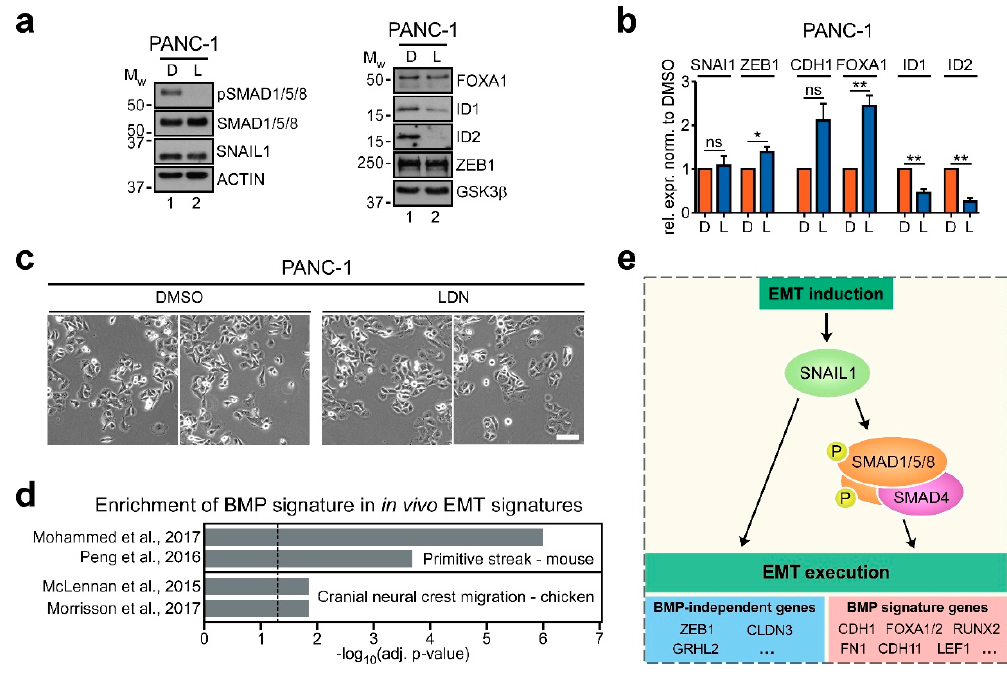
Figure 7. BMP pathway activity partially sustains a mesenchymal state of pancreatic cancer cells and BMP signature gene expression occurs in developmental instances of EMT. ( a ) Western blot analyses of proteins indicated on the right. PANC-1 cells were treated with DMSO or 50 nM LDN193189 (LDN) for 72 h as indicated. Positions of molecular weight (M W ) standards in kDa are given on the left. E-CADHERIN could not be detected. Detection of ACTIN and GSK3 β was used as control for equal loading. Proteins were detected using whole-cell lysates, except for FOXA1, ID1, ID2, ZEB1 and GSK3 β for which nuclear extracts were used. ( b ) qRT-PCR analyses of mRNA expression in PANC-1 cells treated with DMSO or 50 nM LDN193189 (LDN) for 72 h as indicated. Significance was determined using two-tailed one sample t-test. Shown is the mean + SEM; n = 4. Rel. expr.: relative expression normalized to that of GAPDH. ns: not significant. *: p < 0.05, **: p < 0.01. ( c ) Phase contrast images of PANC-1 cells treated with DMSO or 50 nM LDN193189 (LDN) for 72 h as indicated. Two representative fields of view are shown for each condition. Scale bar: 100 µ m. ( d ) Gene set enrichment analysis (GSEA) of BMP signature genes in publicly available sets of genes regulated in EMT-associated processes in di ff erent organisms in vivo. Only genes upregulated by Snail1-HA in LS174T cells were considered. Source publications of the analyzed gene sets are given on the left. Plotted is the negative log10 of the adjusted (adj.) p -value. Vertical dotted line indicates the significance threshold of adjusted (adj.) p -value ≤ 0.05. A detailed list of GSEA results is given in Table S4. ( e ) Model depicting the proposed role of BMP signaling in EMT execution downstream of SNAIL1. Upon induction of EMT and upregulation of SNAIL1, BMP pathway-associated SMAD transcription factor complexes are activated and control a subset of critically EMT-relevant genes. Examples for such BMP signature genes are shown. Note that SNAIL1 regulates additional epithelial and mesenchymal marker genes independently of BMP pathway activity.